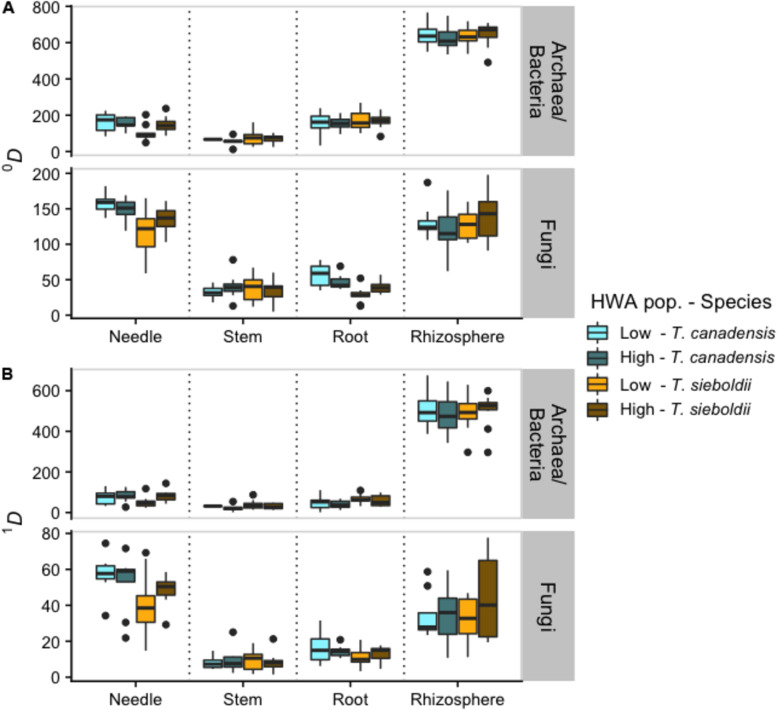
Boxplots representing α-diversity based on Hill numbers (Jost, 2006) of archaea/bacteria and fungi across plant-associated habitats, hemlock woolly adelgid (HWA) population levels, and host species at q = 0 (richness) (A) and q = 1 (analogous to Shannon diversity) (B). Note different axis scales.